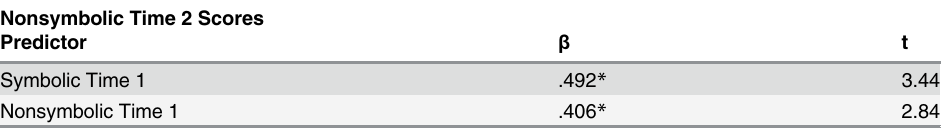
Table 2. Linear regression analysis predicting nonsymbolic scores at Time 2 with symbolic and non- symbolic scores at Time 1 as